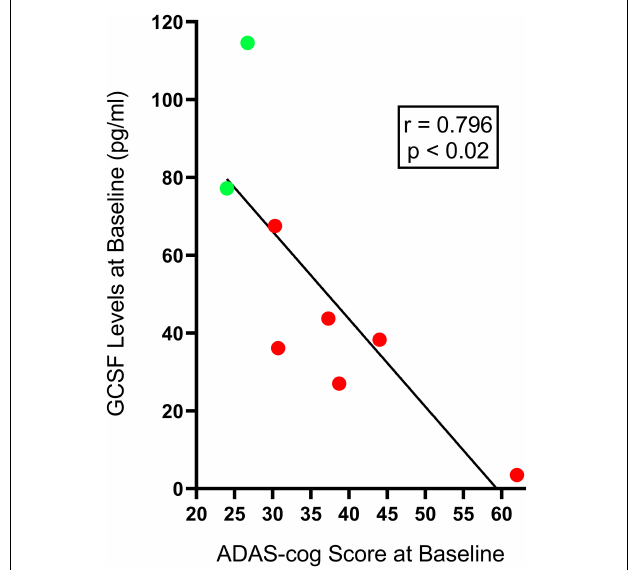
FIGURE 2 | The significant inverse correlation between plasma baseline GCSF levels and baseline ADAS-cog scores in individual AD subjects. Lower baseline GCSF levels were evident in individual AD subjects having poorer (higher) baseline ADAS-cog scores (Group 1, red-filled circles), while higher baseline GCSF levels were found in individual AD subjects with better (lower) baseline ADAS-cog scores (Group 2, green-filled points). This inverse correlation was present for seven of the eight cytokines measures in